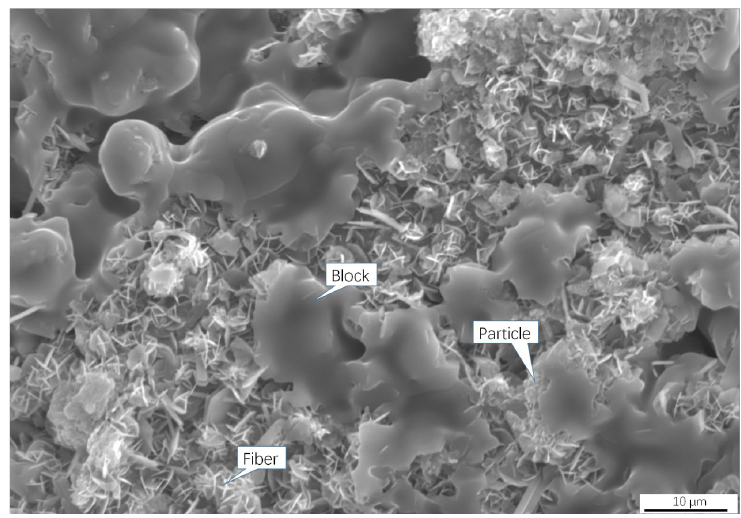
Figure 11. Microstructure of the coagulum.